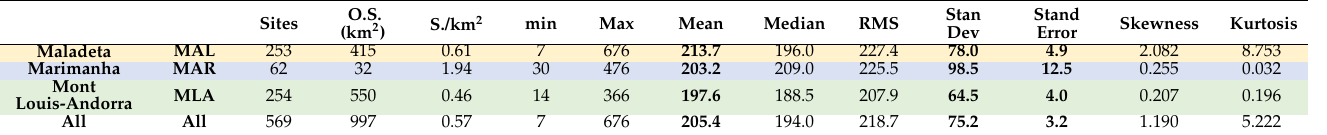
Table 1. Main statistical variables from previous studies in Maladeta (MAL), Marimanha (MAR) and the Mont-Louis Andorra (MAL) granites (based on data by Leblanc et al., 1994 [45]; Antol í n-Tom á s et al. [46] and Gleizes et al. [34] respectively). O.S: Outcropping Surface, S. km 2 ; sites per sq. km/. All susceptibility data are expressed as µ S.I. Note that these colors are kept all along the paper to refer those granites.